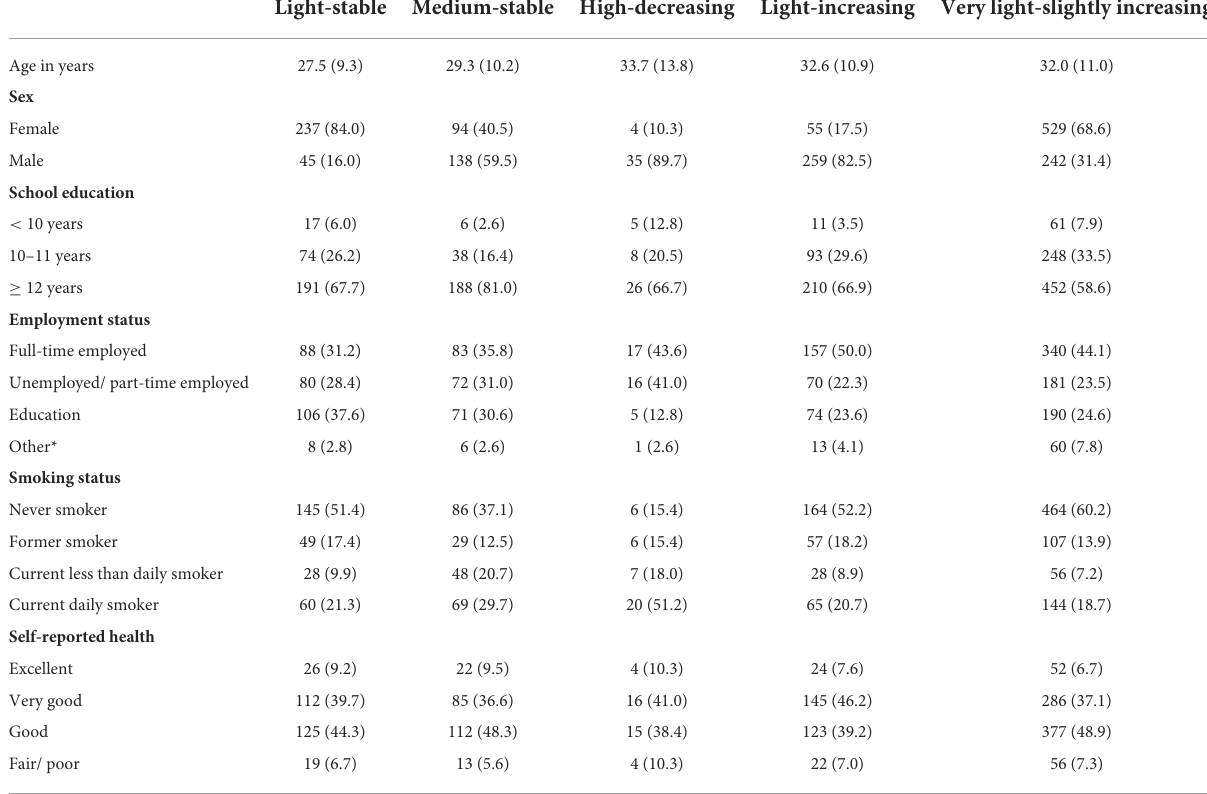
TABLE 3 Baseline sample characteristics by trajectory class (N =